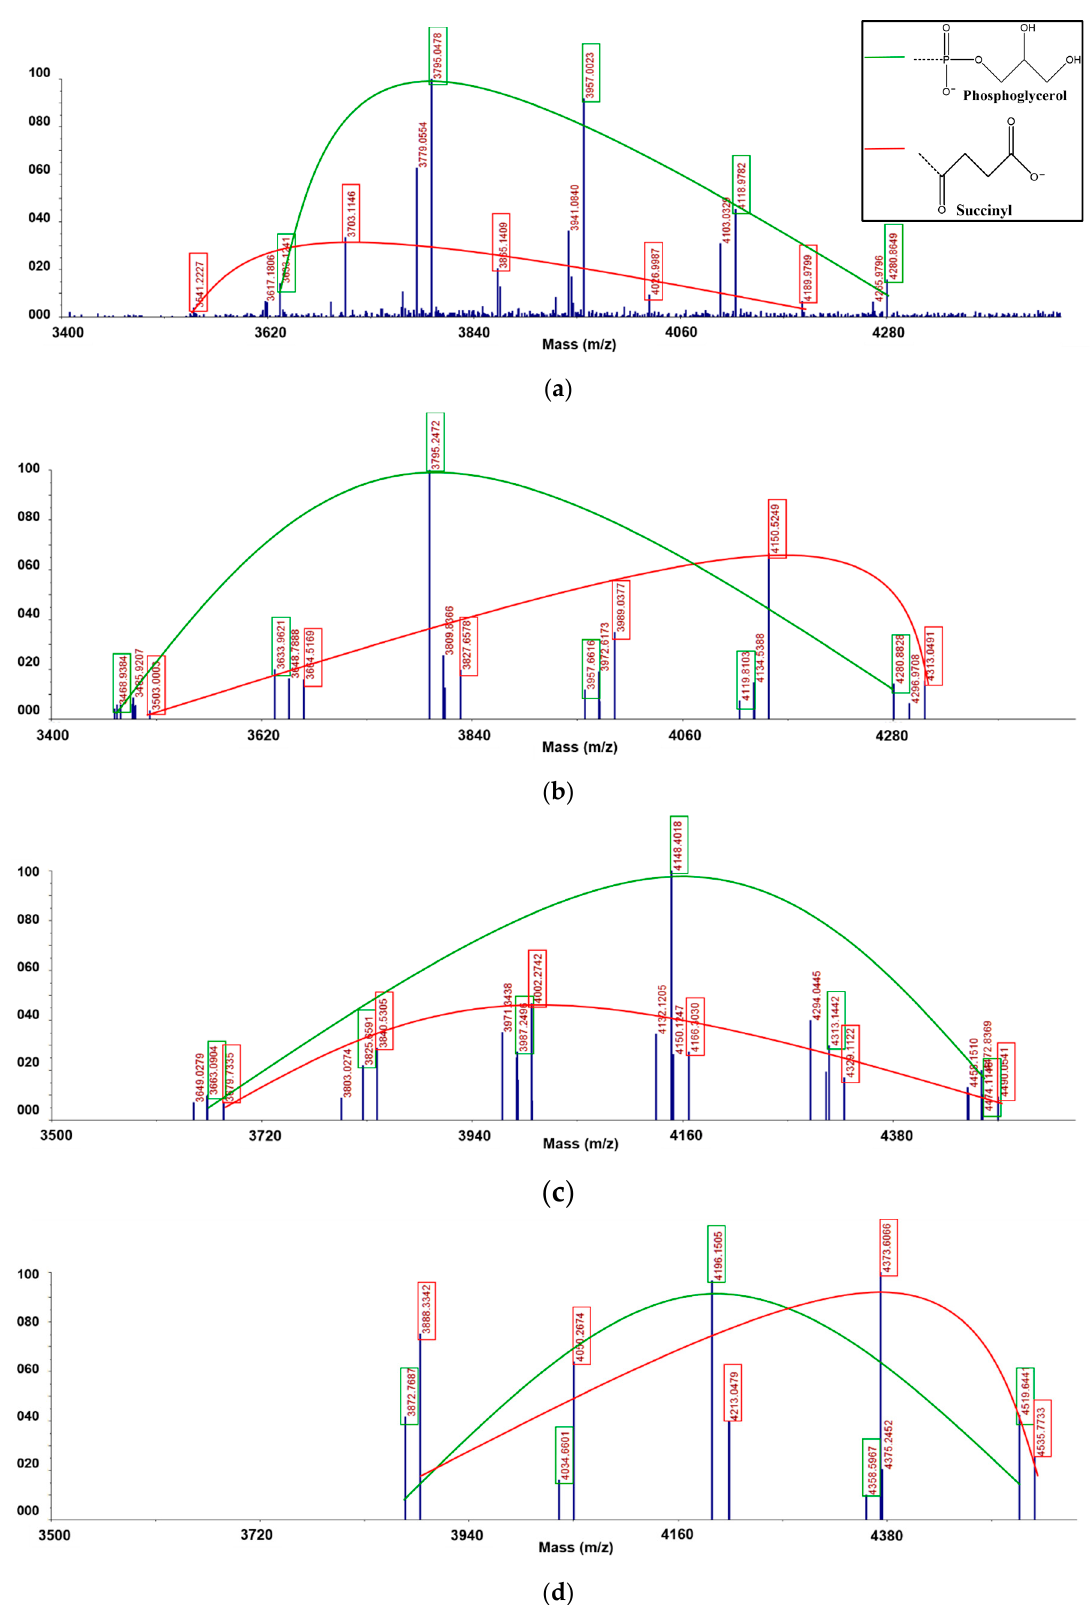
Figure 6. MALDI-TOF mass spectra of anionic CG obtained from ( a ) F1 fraction; ( b ) F2 fraction; ( c ) F3 fraction; ( d ) F4 fraction; acquired in positive ion reflector mode. The mass spectrums resulted from peak deisotoping based on the generic formula [C 6 H 12 O 6 ] n showing various sodium and potassium adduct peaks. Each green and red curve shows the molecular weight distribution of SCG and GCG, respectively.